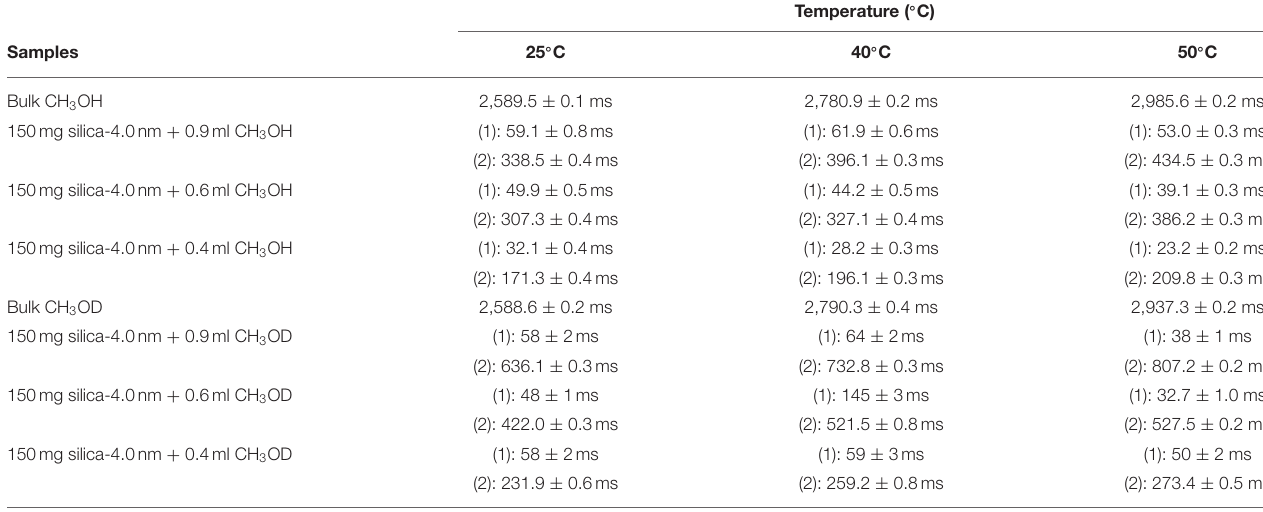
TABLE 5B | Transverse magnetization relaxation times (T 2 ) of confined CH 3 OH obtained after sonication of the mixtures for 15 min.